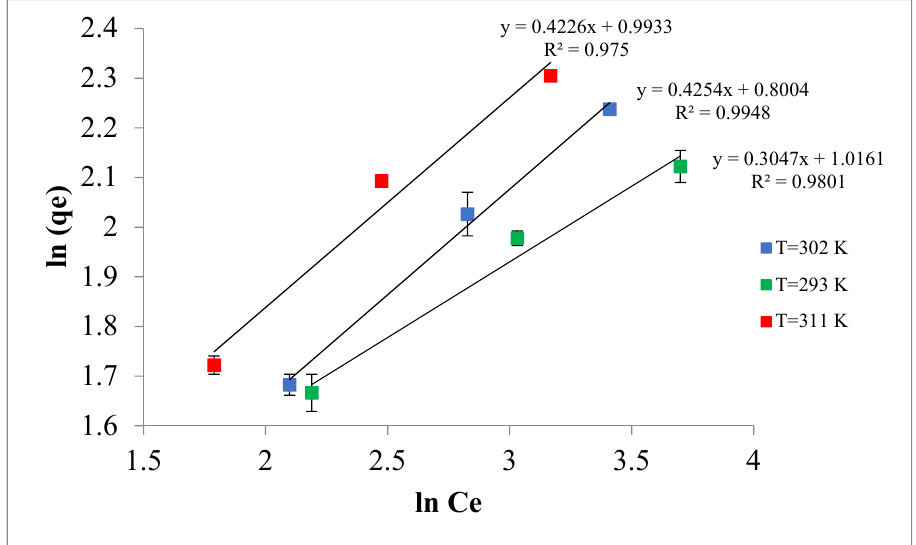
Figure 14. Freundlich linear isotherm representation (adsorbent dose 1% by weight, pH 5.0, contact time 24 h).